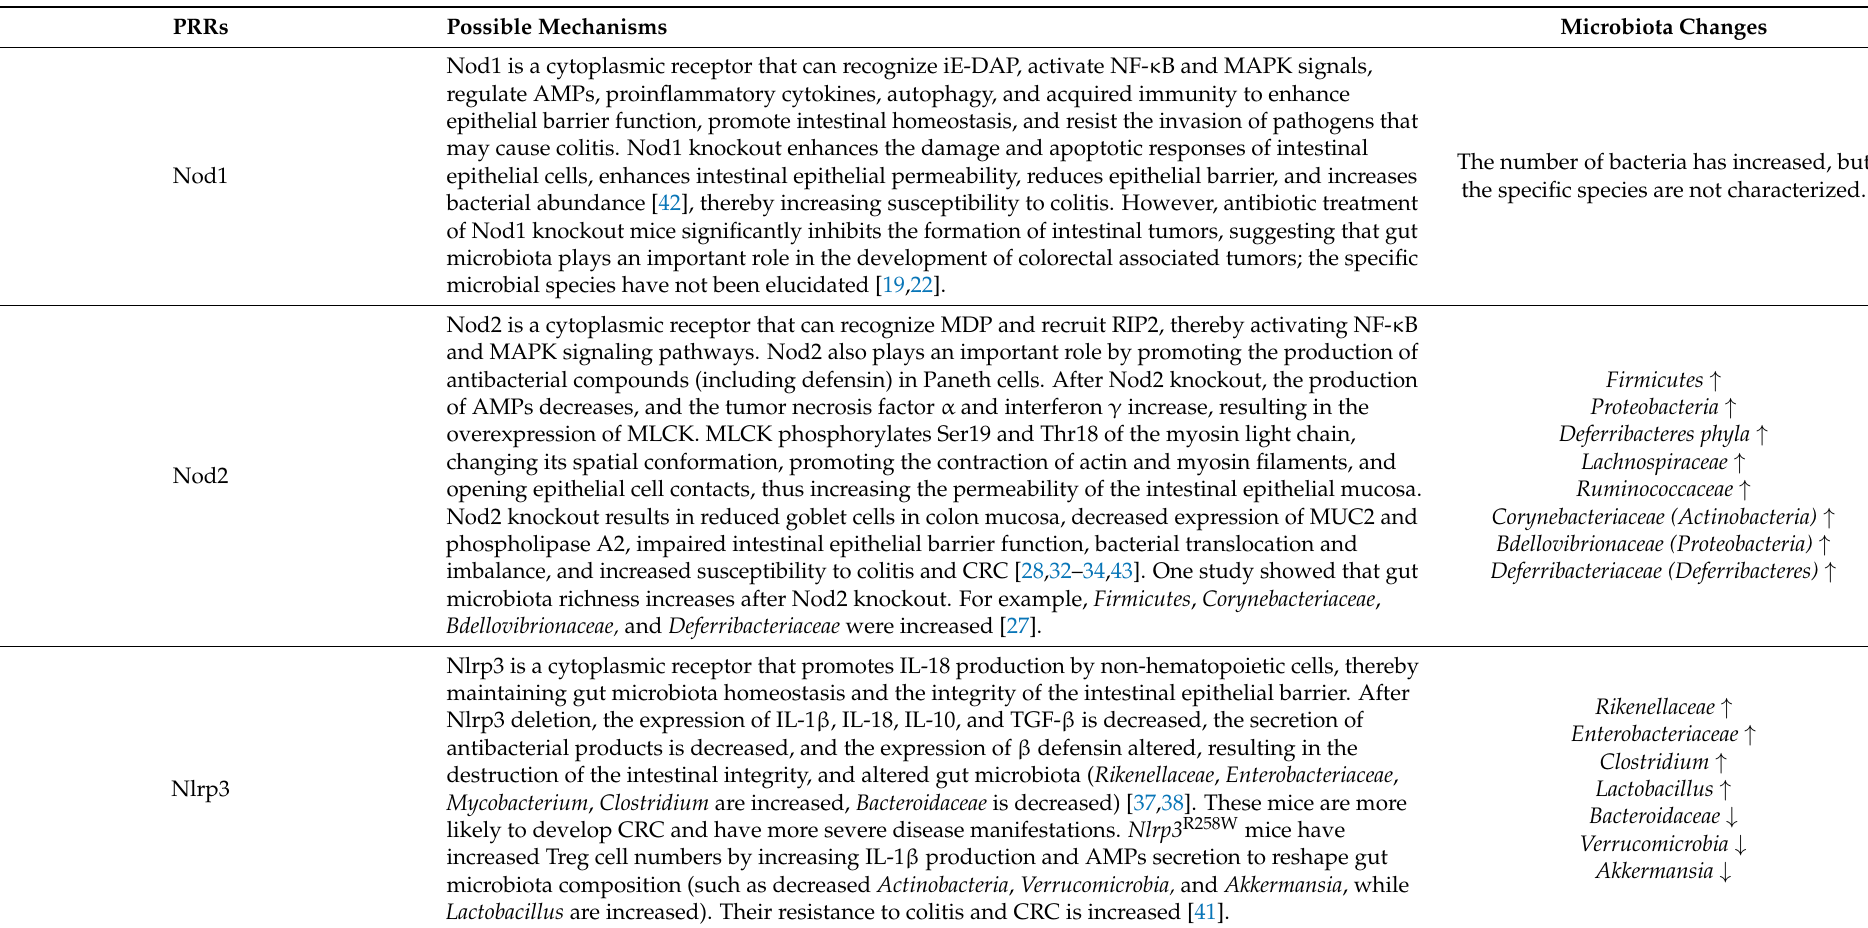
Table 1. Alteration of gut microbiota by